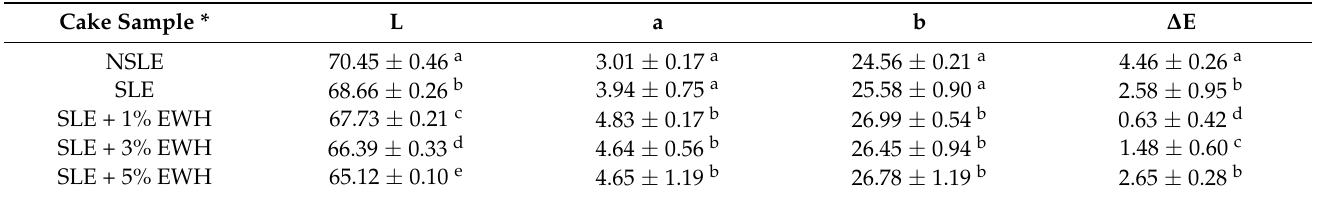
* Values are expressed as means ± standard deviations, and there is a significant difference between the averages indicated by different letters in the same column ( p < 0.05). L: black and white/+ whiter–blackish; a: reddish green/+ reddish–greenish; b: yellowish blue/+